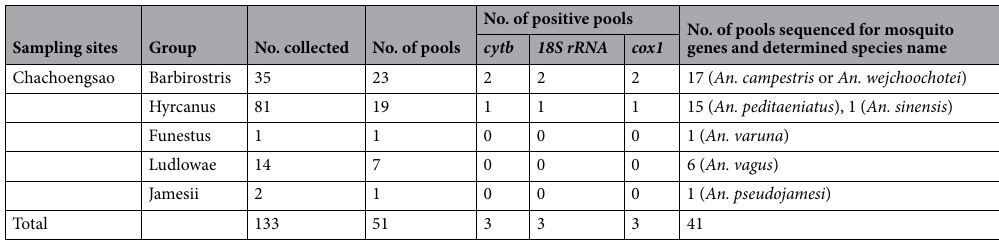
Table 1. Summary of P. bubalis ’s PCR screening results of anopheline mosquitoes collected from the buffalo farm.